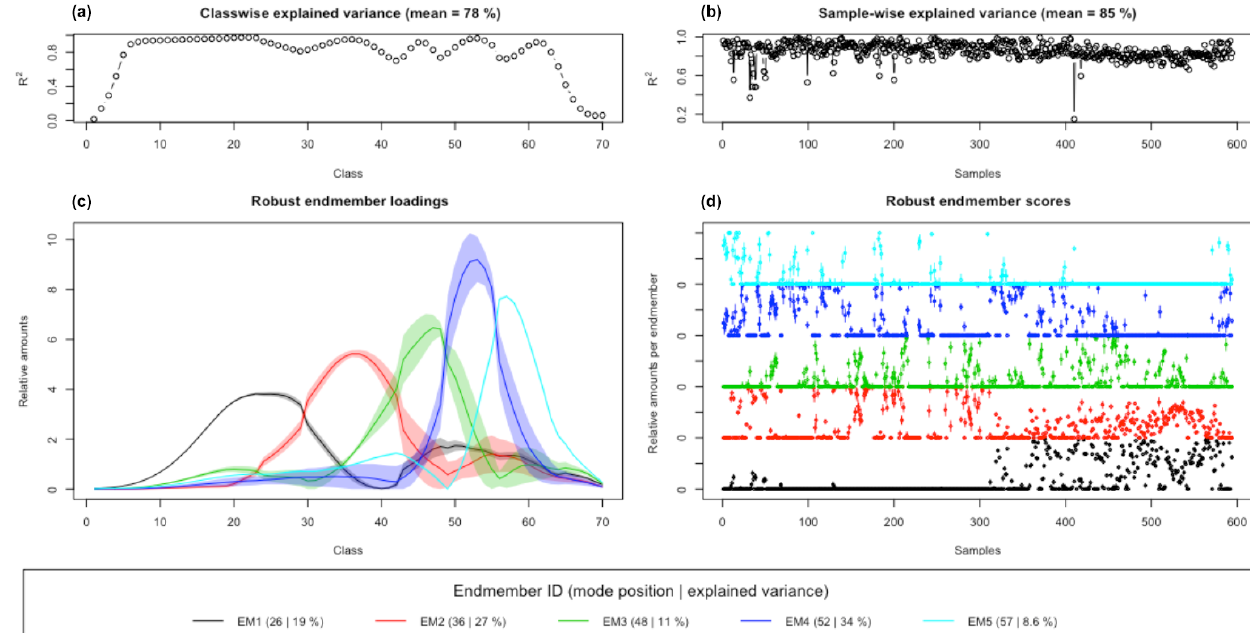
Figure A1. Default graphical output of robust EM() as part of the compact protocol, including class- and sample-wise explained variances (a) and mean robust loadings as line graphs, mean robust scores as panels of points (b) . Polygons around loadings and bars around scores represent 1 standard deviation. A legend with main mode position and explained variance of each endmember. Classes span from 0.19 to 1784µm. For further reading see Dietze and Dietze